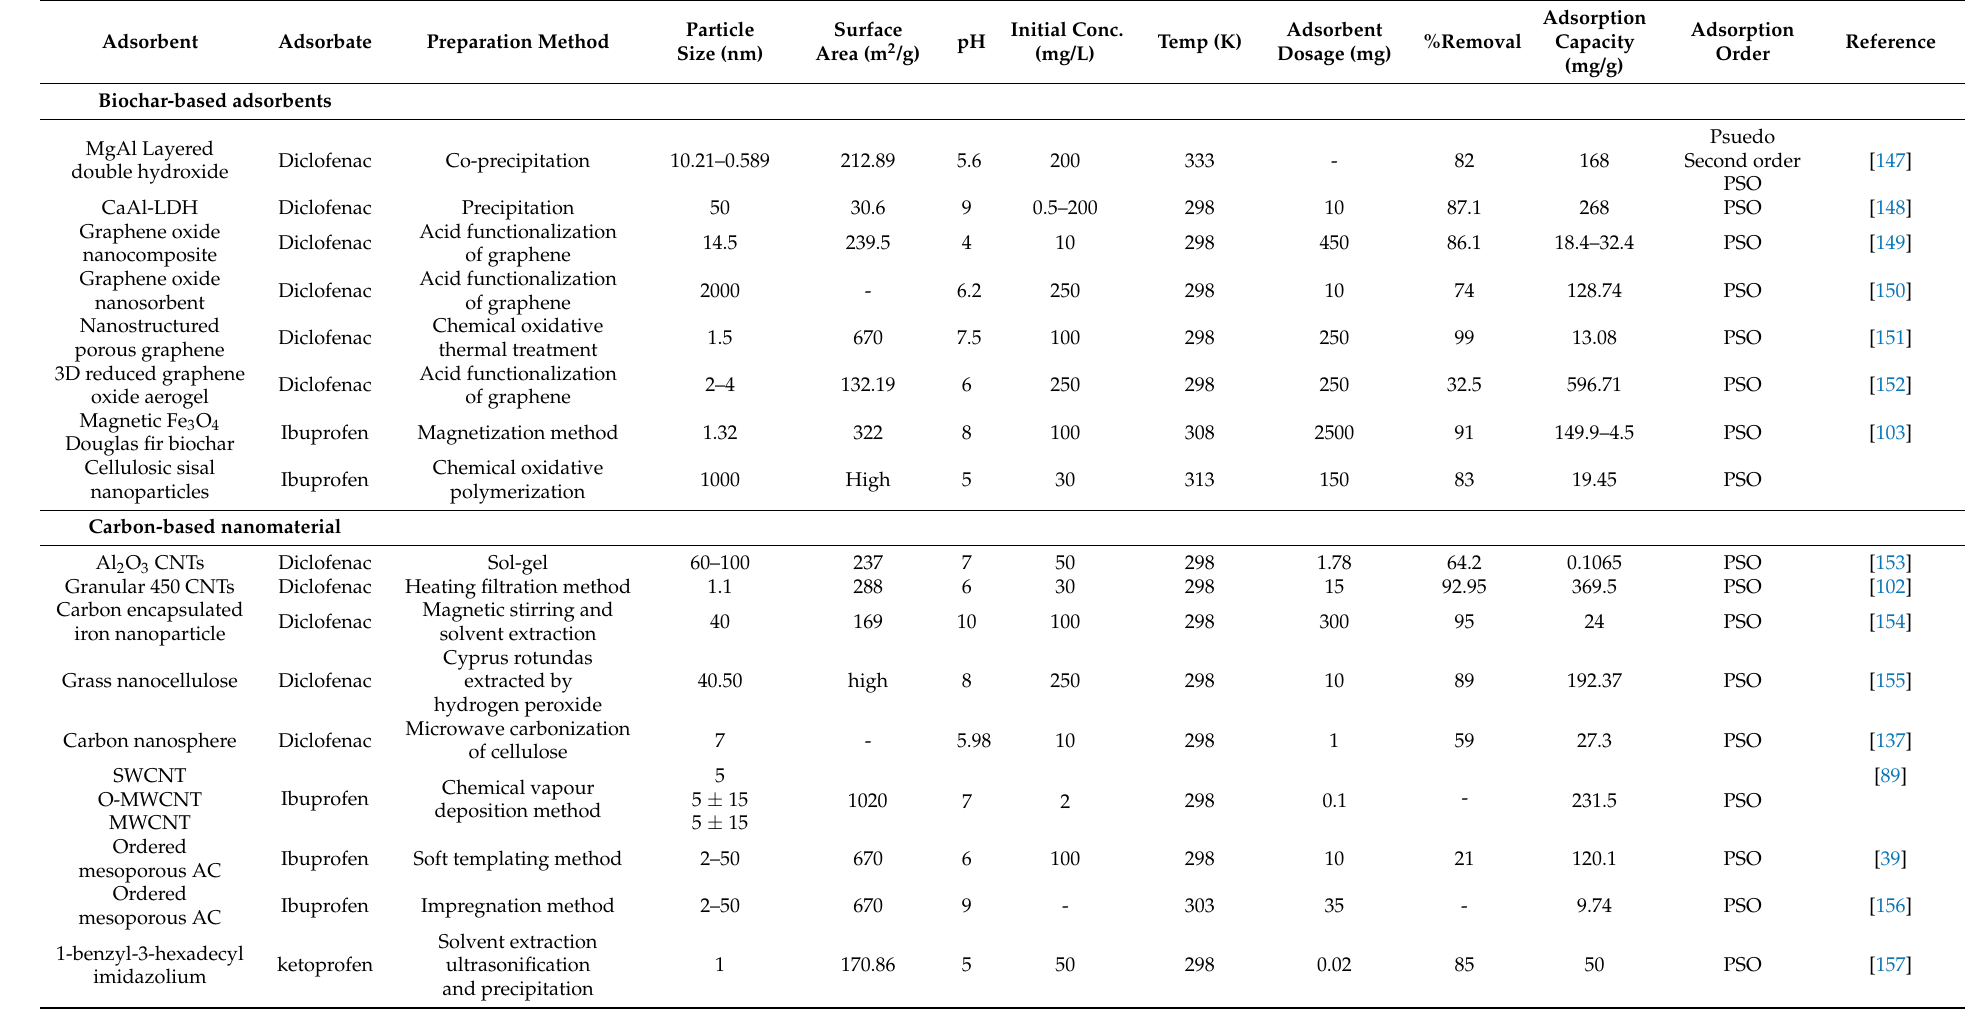
Table 2. Adsorption capacity, order of adsorption and surface area values for the removal of NSAIDs and ARV drugs by different